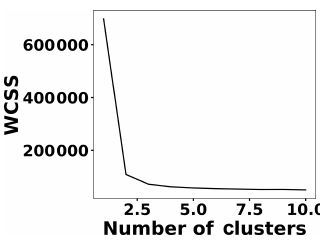
Figure 5. The elbow plot suggests two centroids for clustering the spectra set.